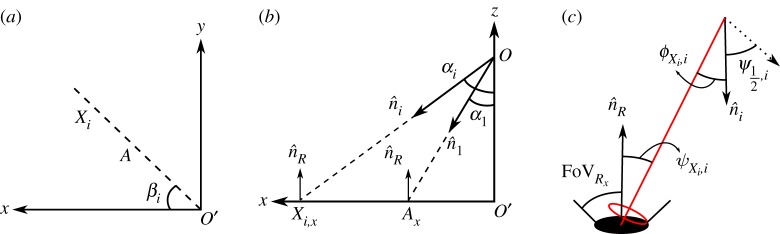
Illustration of orientation of LEDs. βi, αi and n^i represent horizontal orientation, vertical orientation and normal of LEDi, respectively; and n^R represents the receiver normal. The point O represents the location of the LED array on the ceiling. The points A and Xi represent the directed point of LED1 and LEDi on the XY-plane. The points Ax, Xi,x and O′ represent x-axis component of the points A, Xi and O, respectively. (a) XY-axes, (b) XZ-axes, (c) gain geometry. (Online version in colour.)